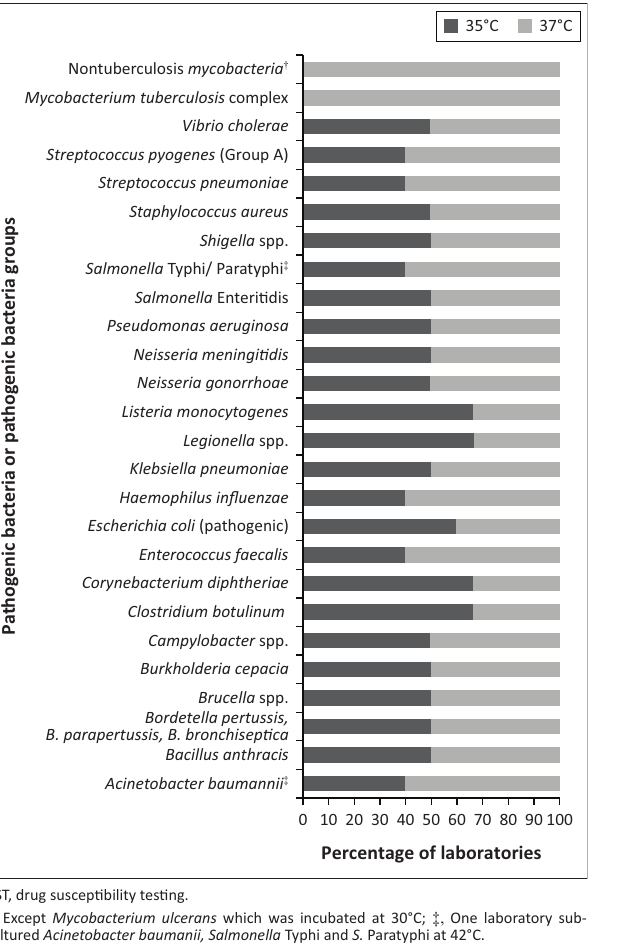
FIGURE 1: Incubation temperature in 12 laboratories from seven countries for isolation, subculture and DST of 26 pathogenic bacteria or pathogenic bacteria groups frequently isolated from clinical